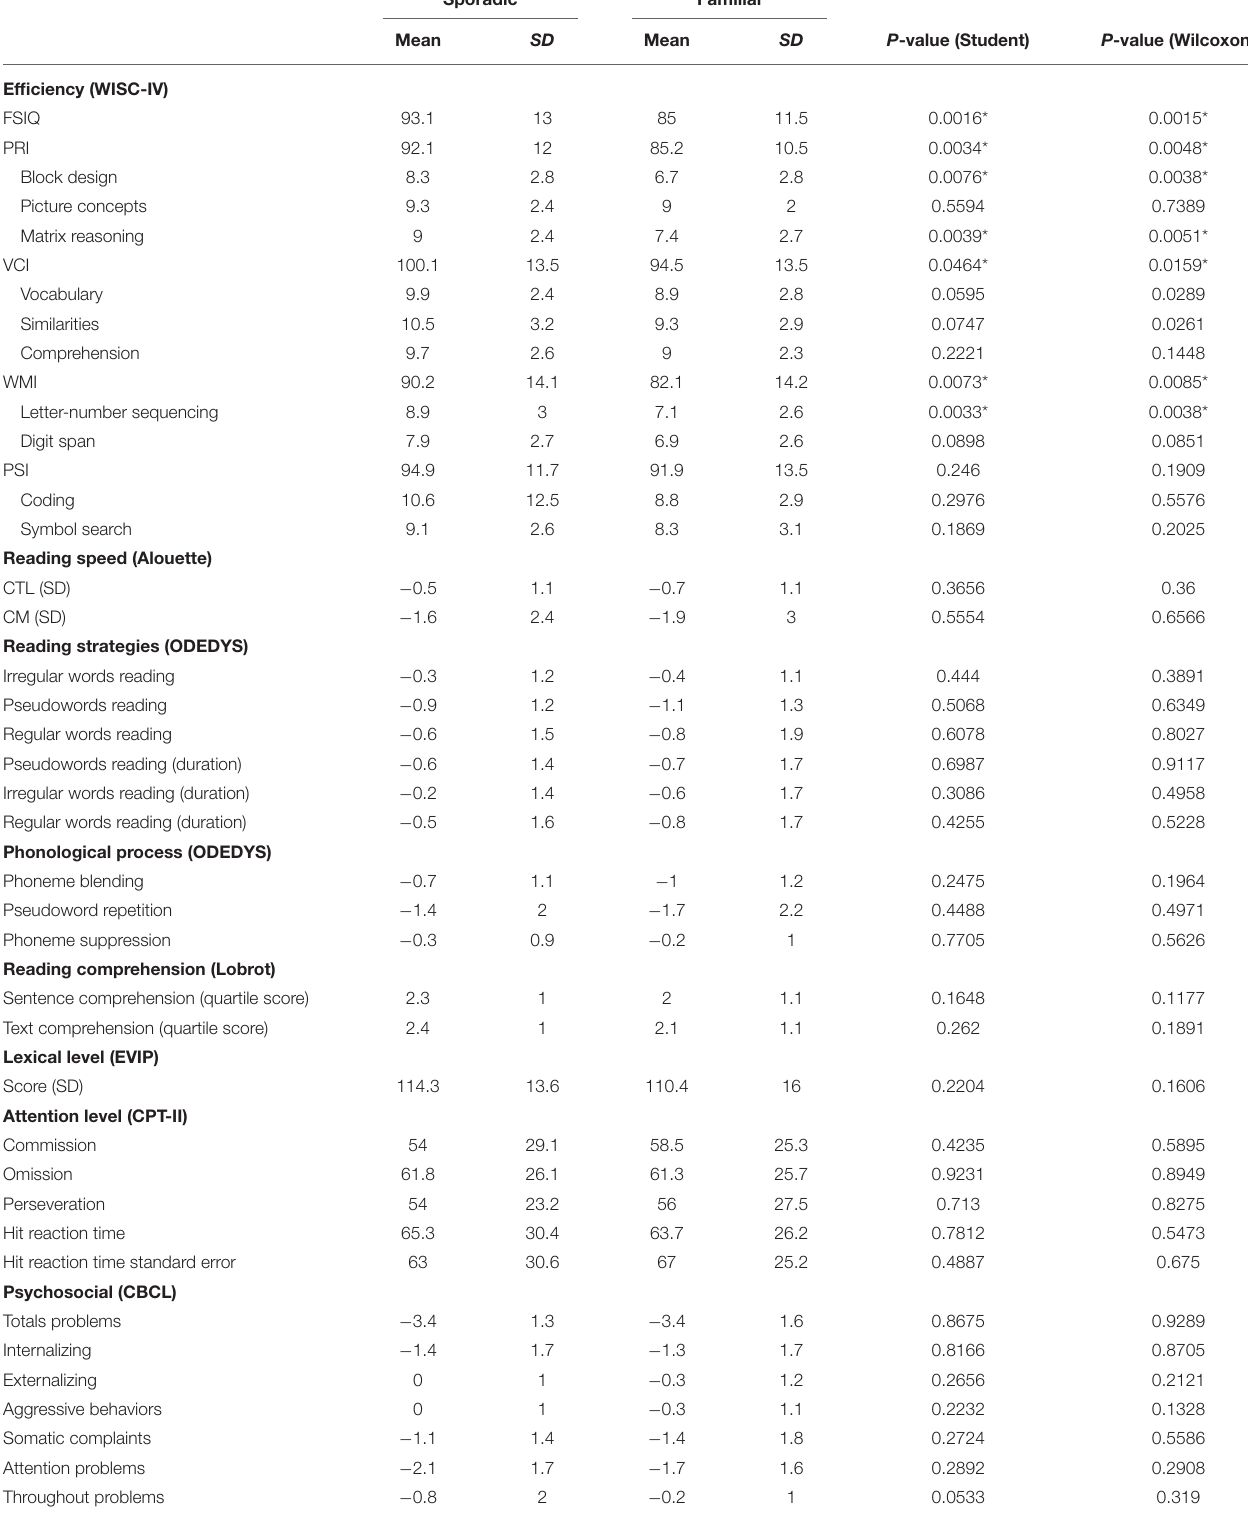
TABLE 2 | Clinical Characteristics of the Sporadic and Familial